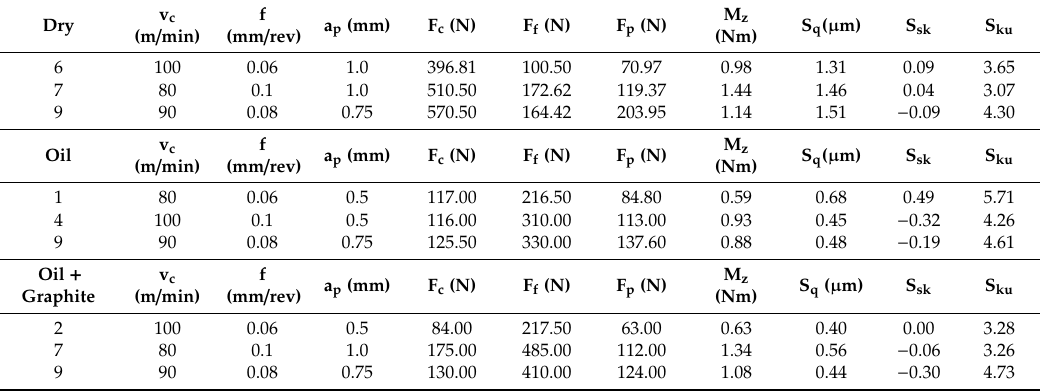
Table 11. Samples chosen randomly for testing the training of the ANNs created.